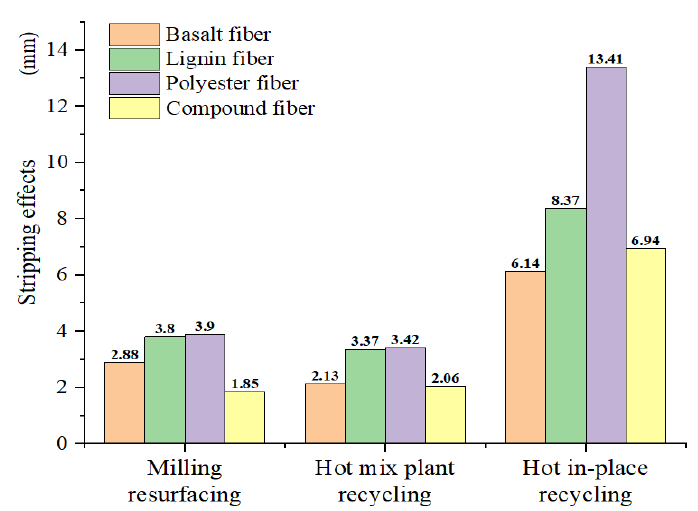
Figure 24. Stripping effects of fiber asphalt mixtures.